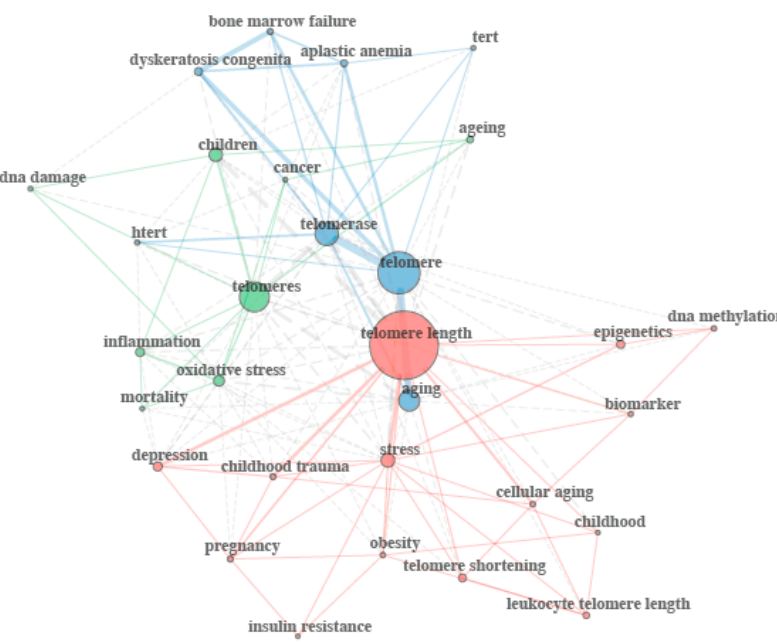
Figure 5. Author keyword co-occurrences network map.